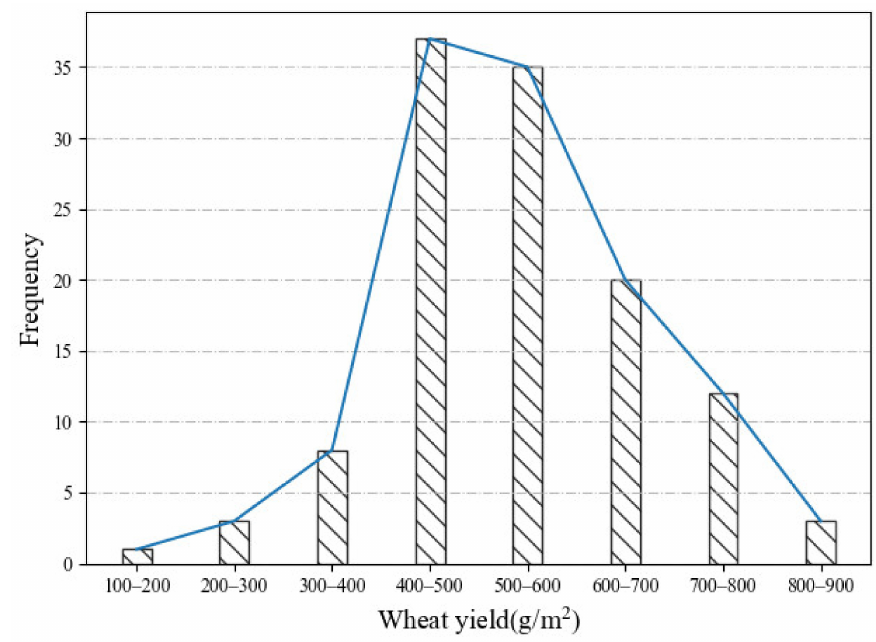
Figure 3. Distribution of the yield of the sampled